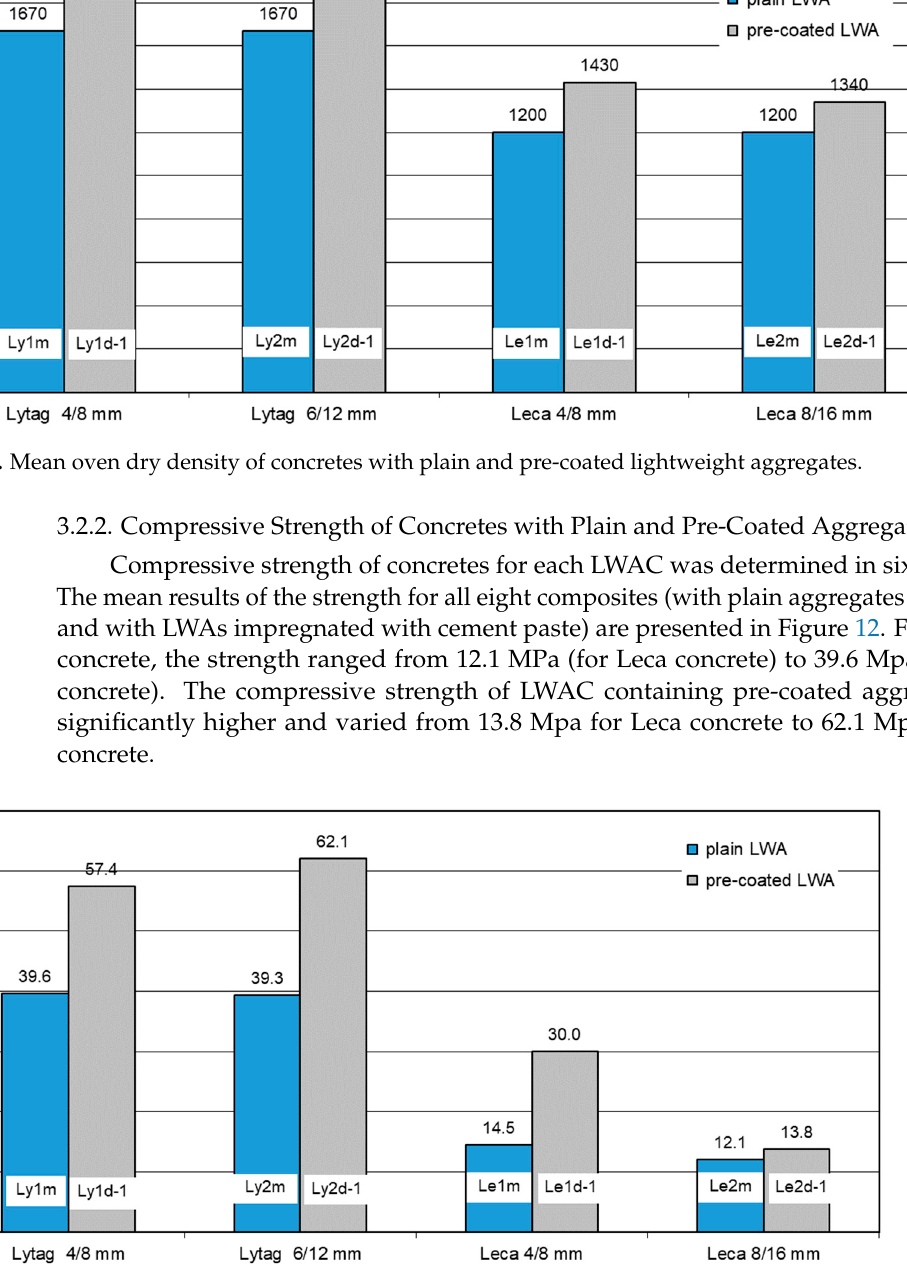
Figure 10. Development of water absorption in time for Liapor 8/12 mm impregnated with cement pastes.